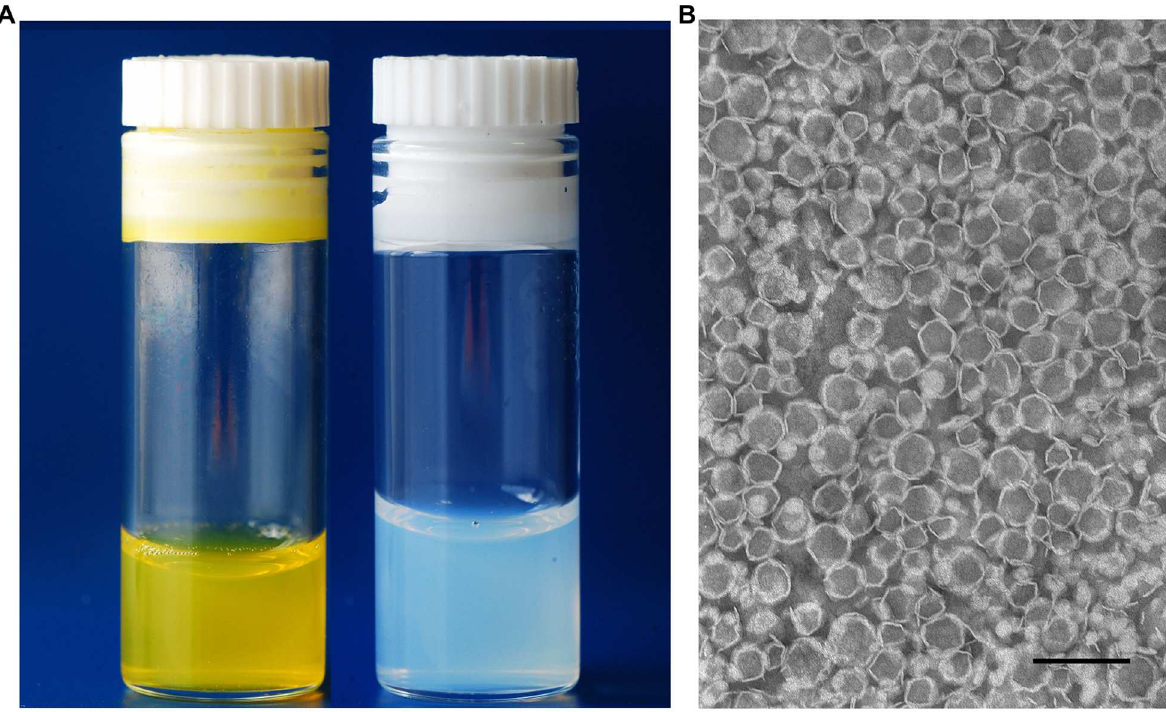
Fig 1. Appearance of liposomal formulations. (A ) Cur-loadedliposomes (left) and free liposomes (right) . (B) TEM images of Cur- loadedliposomes(H5 formulation).Scale bar represents 200